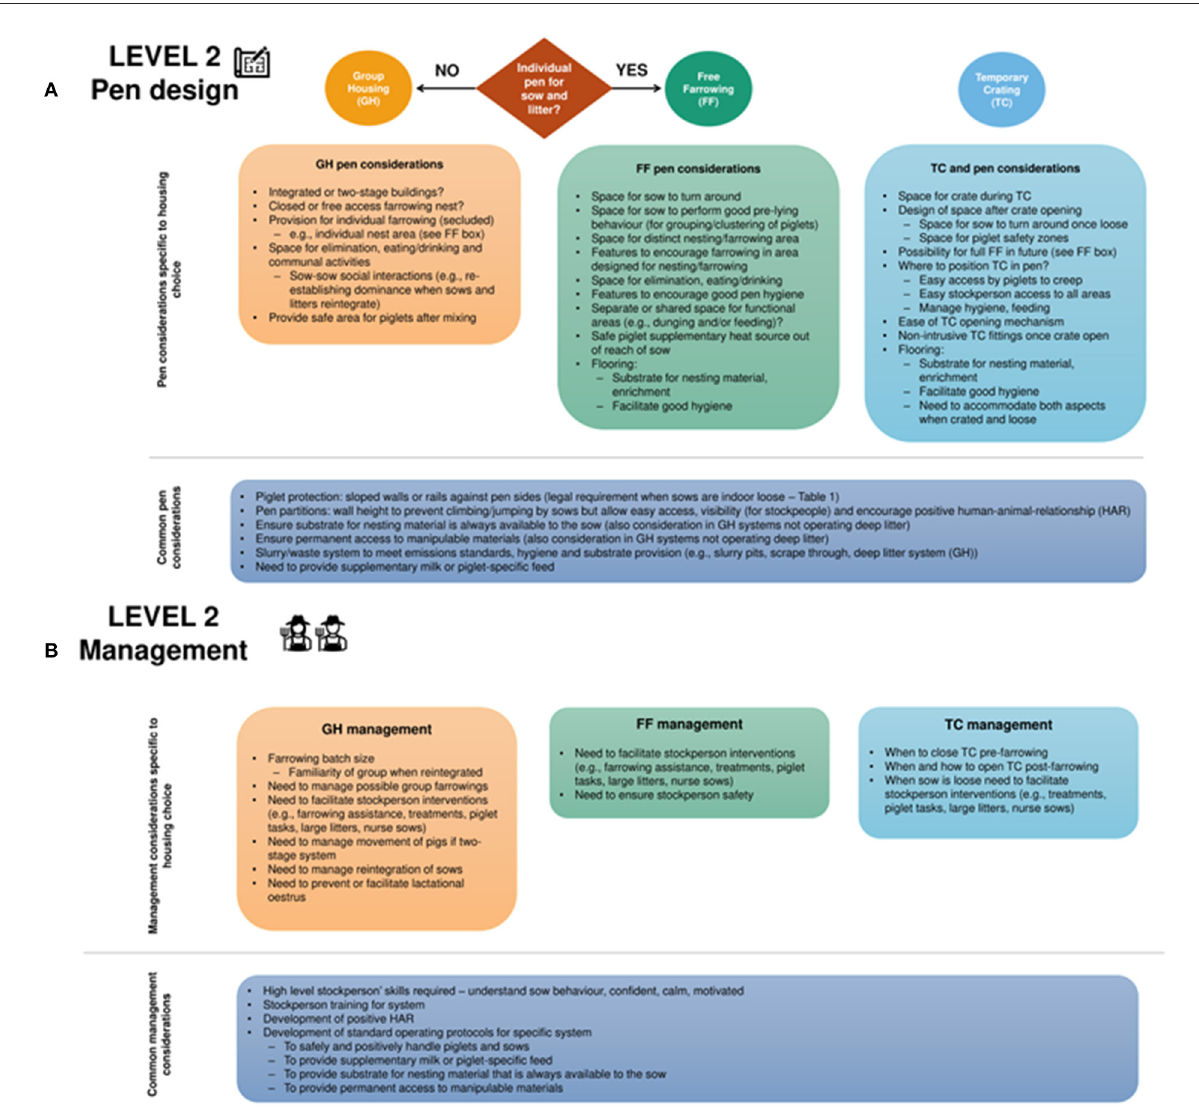
FIGURE3 Level 2 pen (A) and management (B) considerations once a housing system has been chosen. Specific considerations for FF (free farrowing), TC (temporary crating), and GH (group housing) are given in individual boxes. Cross-referral between boxes is indicated in the text. Some considerations are common to all